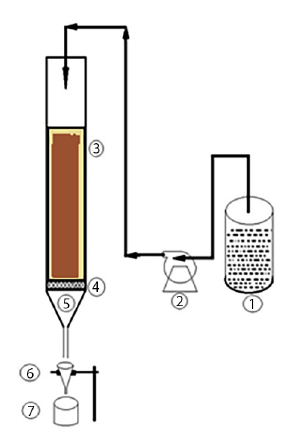
Figure 1. Schematic diagram of experimental set up of column